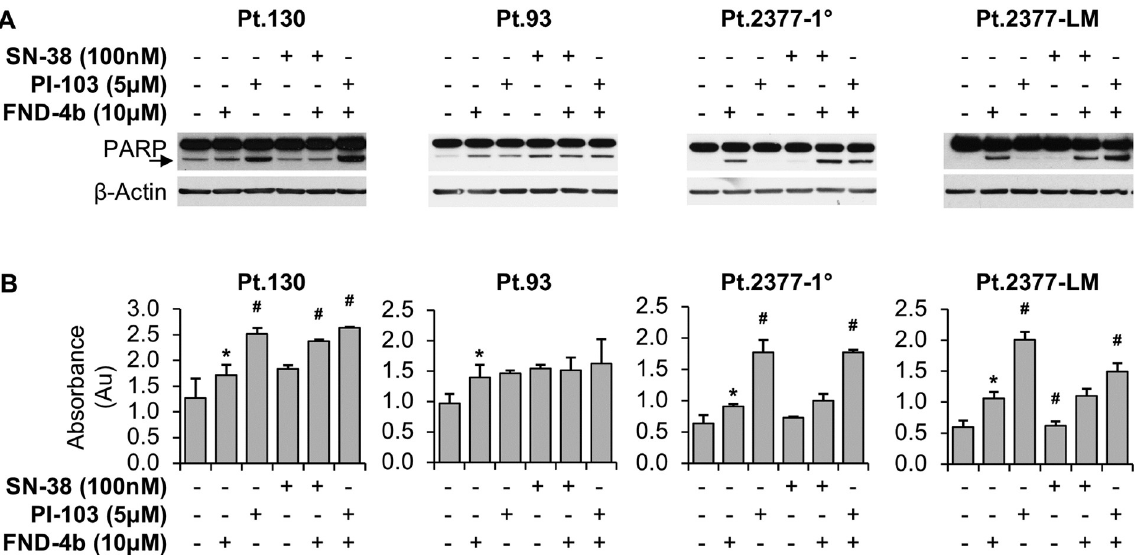
Fig 6. Apoptosis of PDX-derived CRC cell lines treatment combinations. (A) Western blot analysis of PDX-derived CRC cell lines treated with 10 μ M FND-4b, 5 μ M PI-103, and 100nM SN-38, alone and in combination versus untreated control (media alone) for 24h duration. PARP cleavage is indicated by an arrow; β -actin was used as a loading control. The images are representative of three independent experiments. In all CRC cell lines, PARP cleavage was increased as a result of FND-4b treatment compared to untreated control. (B) DNA fragmentation measured by Cell Death ELISA Assays of PDX-derived CRC cell lines treated with 10 μ M FND-4b, 5 μ M PI-103, and 100nM SN-38, alone and in combination for 48h duration. Graphic representations are the mean ± SD of DNA fragmentation plotted as absorbance (Au); each measurement was performed with 3 replicates. � p < 0.05 vs. control and #p < 0.01 vs. FND-4b